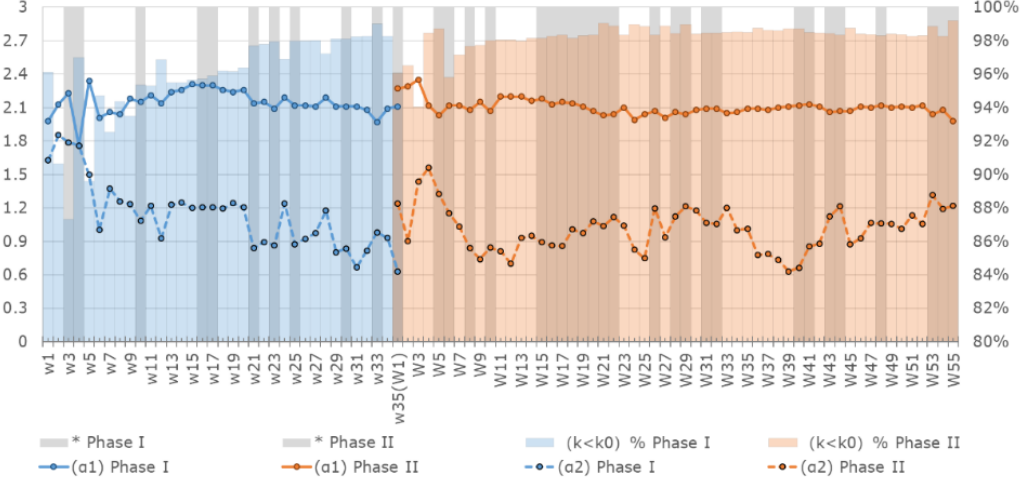
Figure 10. Evolution of scale-free features. Note: In the horizontal axis, w i and W i are labels of the time windows for Phase I and Phase II, respectively; the series “( k < k 0 ) %” is the proportion of firms whose trading partners are below the threshold k 0 of the broken power law. The vertical axis on the left is for the exponents of α 1 and α 2 ; the vertical axis on the right is for the series “( k < k 0 ) %”; the shadow column indicates that the broken power law model was invalid in the period.